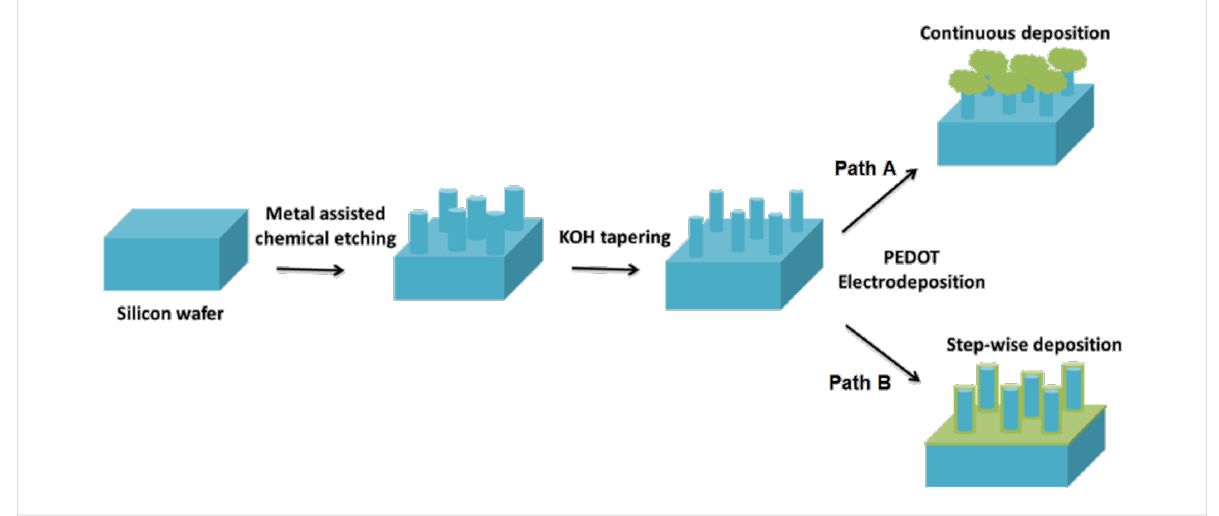
Figure 13: Schematic illustration of the processes resulting in PEDOT/SiNW hybrid structures. (a) Continuous electrodeposition leads to a mush- room-like morphology of PEDOT (green) on the tips of SiNW (blue), while (b) a step-wise deposition aids in the formation of a conformal PEDOT layer (green) surrounding each individual SiNW (blue).